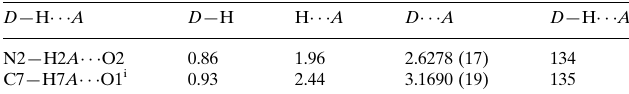
Hydrogen-bond geometry (A˚ , (cid:2)